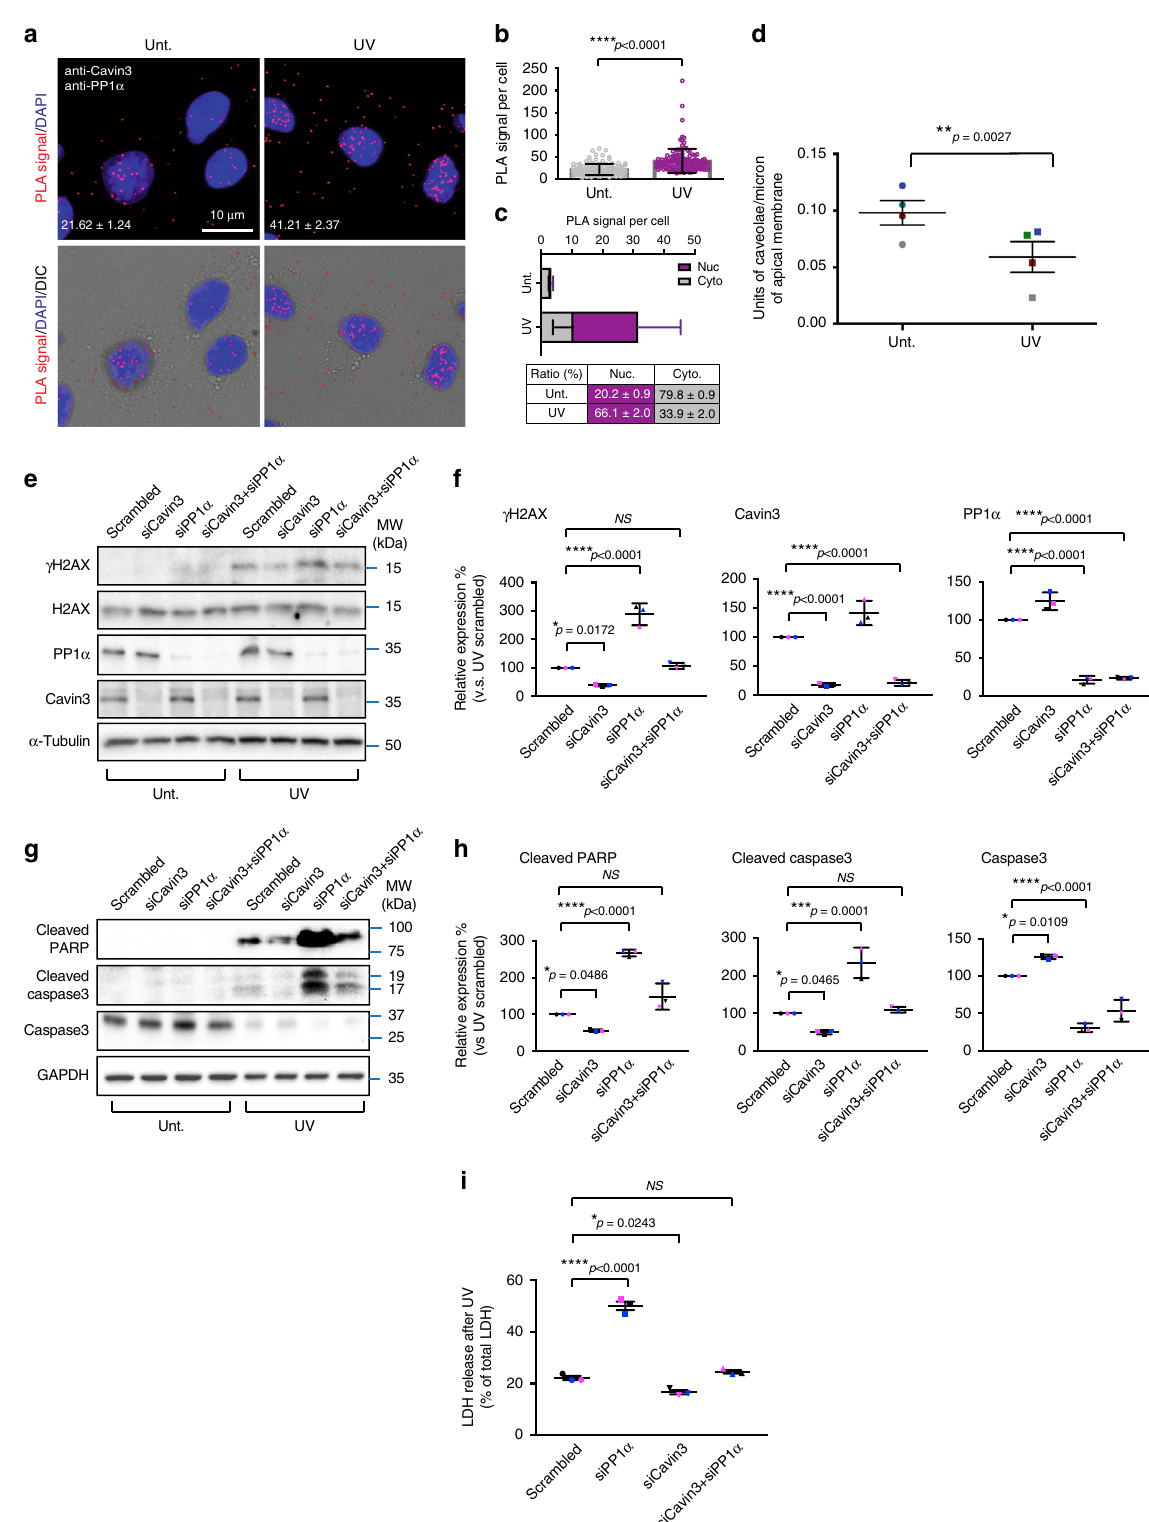
or Cavin3-GFP only in response to UV treatment suggesting the formation of a UV-induced complex between these proteins (Fig. 6c, d). PLA further con fi rmed a predominant nuclear association of endogenous γ H2AX and PP1 α (82.3 ± 8.6%; Fig. 6e, f), as well as γ H2AX Cavin3 (83.5 ± 1.5%; Fig. 6g, h), speci fi cally after UV treatment.